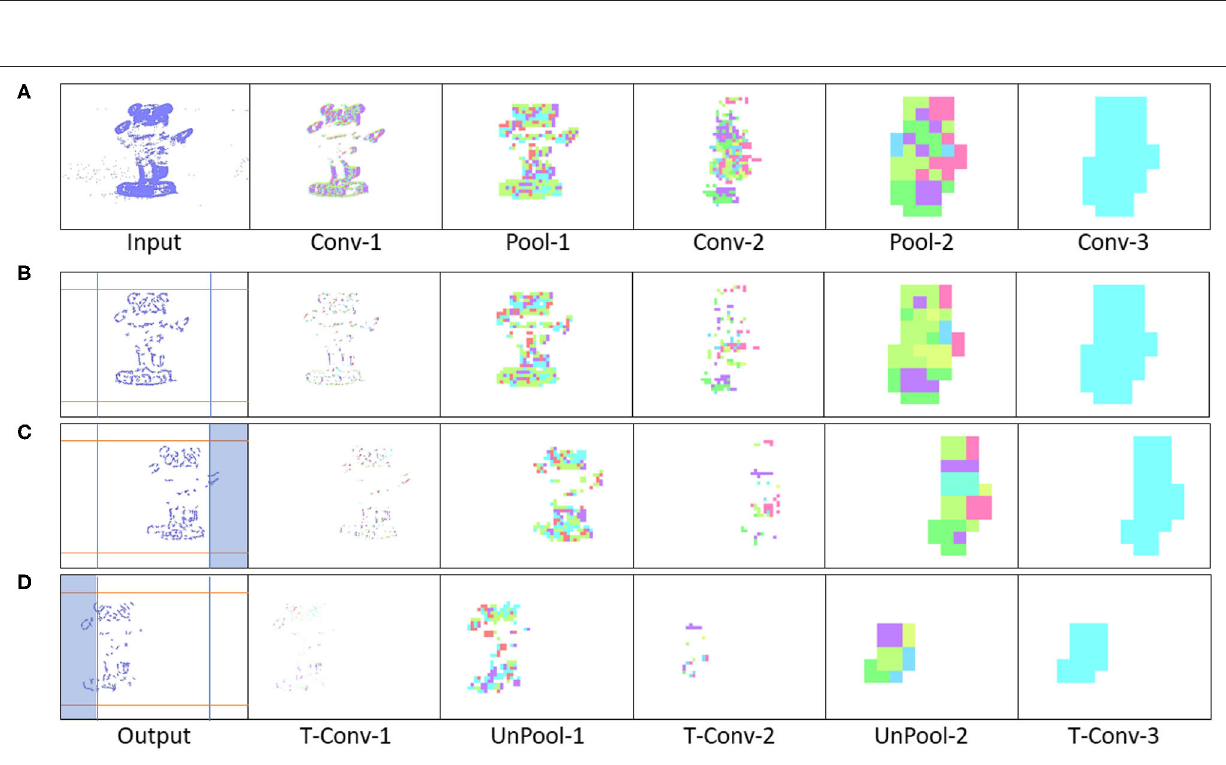
Frontiers in Neurorobotics | www.frontiersin.org